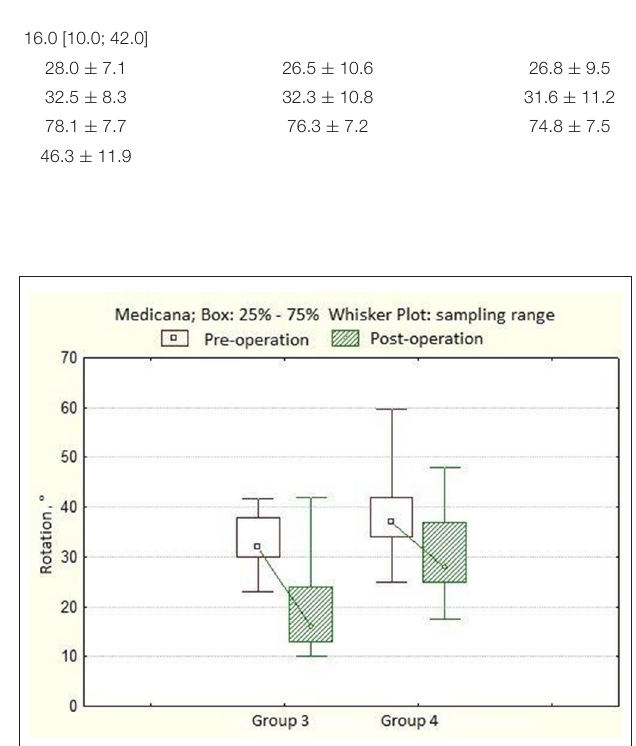
TABLE 3 | The main descriptive statistics for the indicators of the third group, n = 20. Before surgery After surgery One year Three years after surgery after surgery Scoliosis angle in standing position, ◦